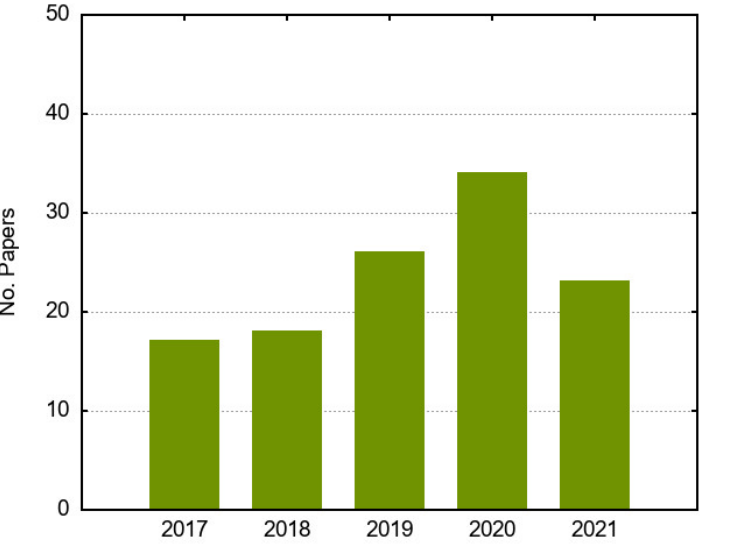
Figure 3. Year-wise distribution of publications.